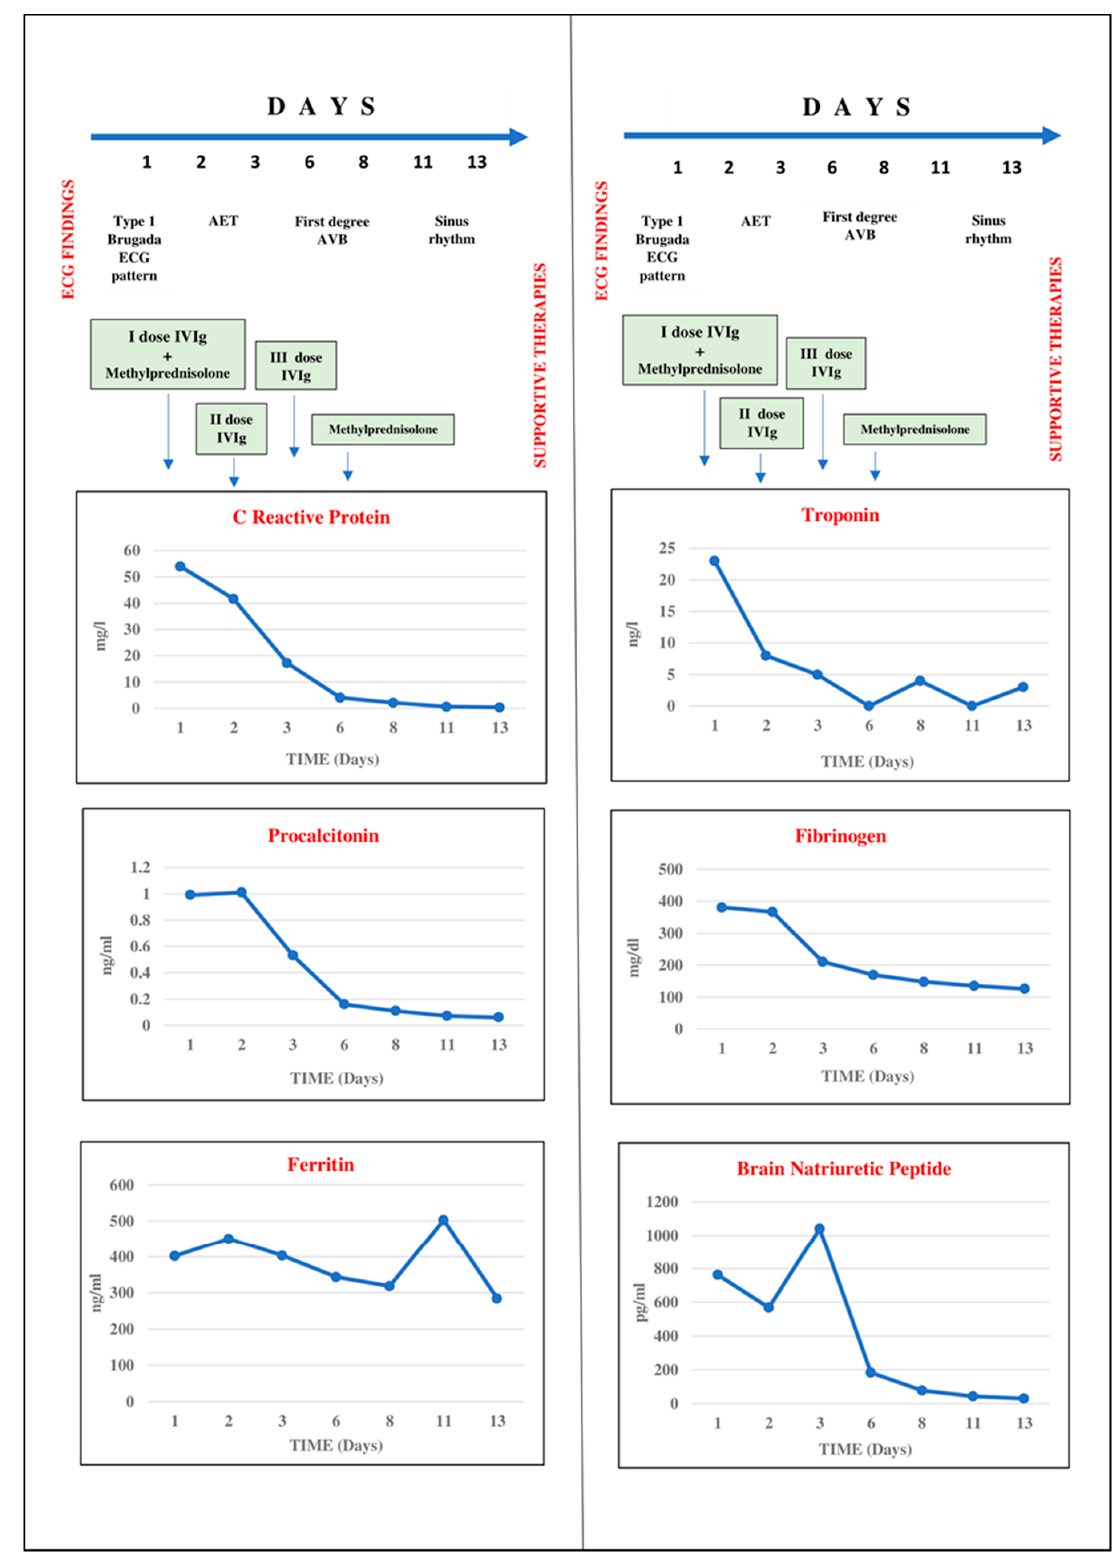
Figure 3. Progressive improvement of inflammation and cardiac markers and ECG normalization during treatment with intravenous immunoglobulins and methylprednisolone boluses. Troponin on admission was 23 ng/L (normal reference value for age < 14) and normalized at the 2nd day of treatment.